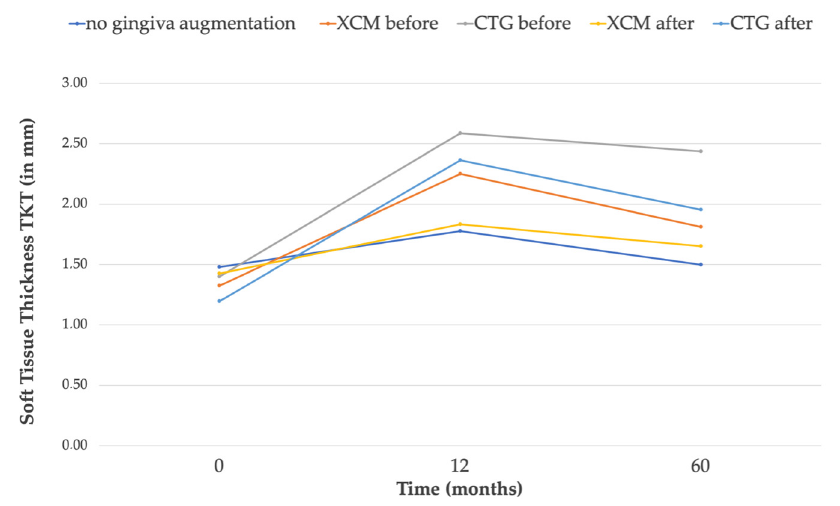
Figure 6. Soft-tissue thickness change for individual groups at the 5-year follow-up. Simplified chart.